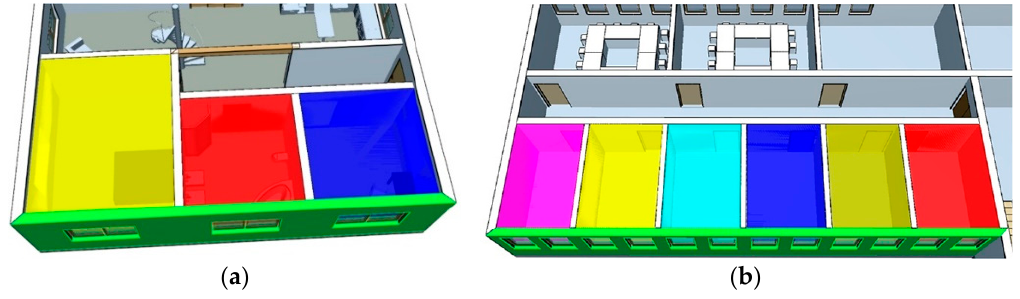
Figure 1. One ‘green’ wall can be shared by multiple IfcSpace objects. ( a ) The BIM model named FZK Haus. ( b ) The BIM model named Office Building.